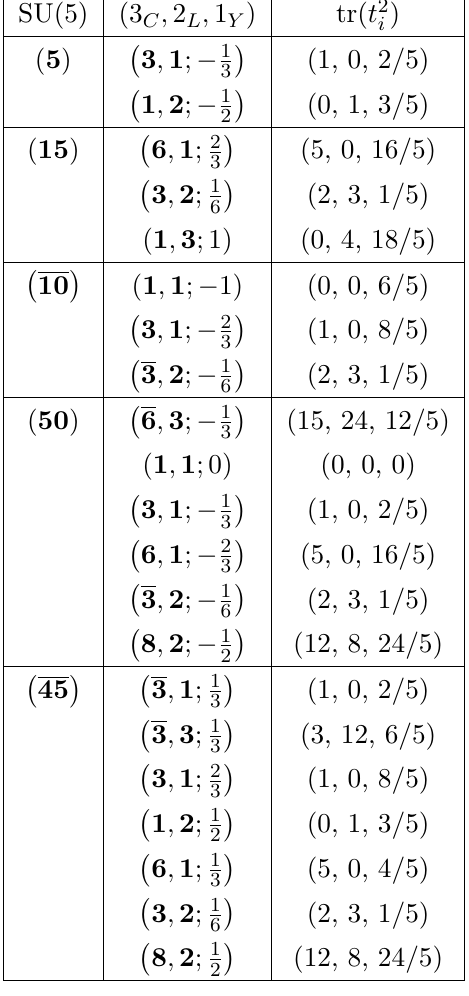
Table 6 . Decomposition of the representation 126 under SU(5) and one-loop coe(cid:14)cients. validity of some of the Georgi-Jarlskog [70] type mass